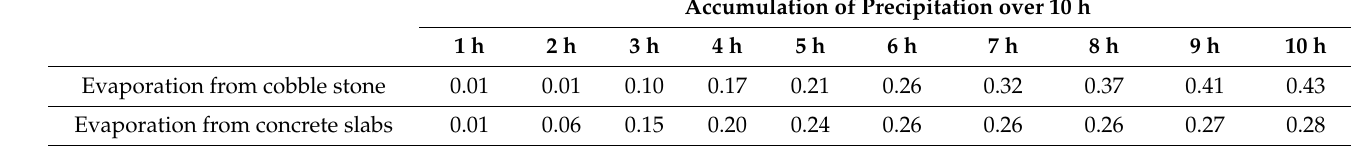
Table 1. Correlation between the precipitation accumulated over 10 h and evaporation from the two pavements.